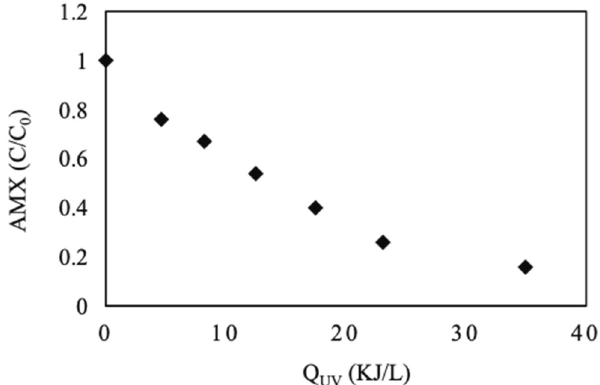
Figure 4. AMX degradation under solar irradiation, and optimised conditions in systems used by Moosavi and Tavakoli, reproduced with permission [54]. Copyright (2016), Springer Nature. Springer-Verlag Berlin Heidelberg.